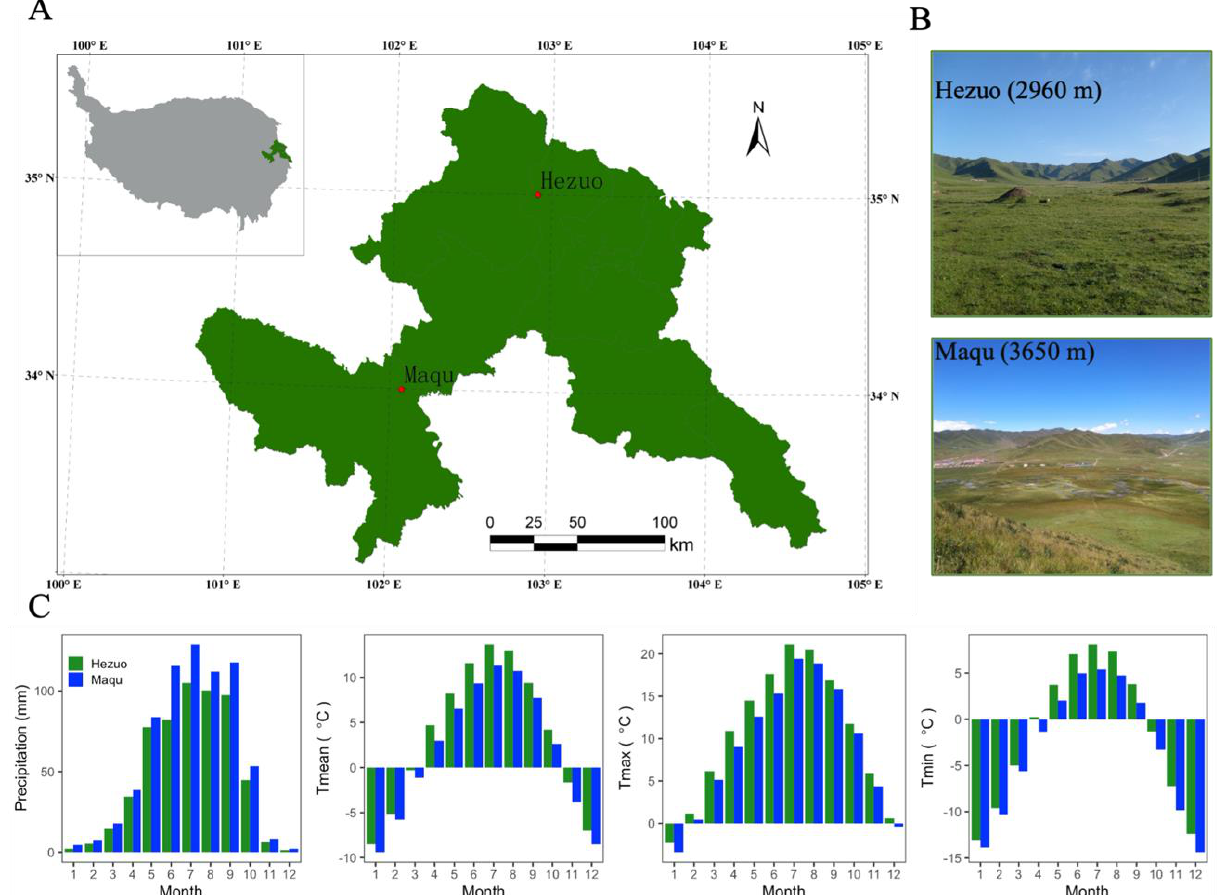
Figure 1. Site location in the Tibetan Plateau (Panel A ), the vegetation landscape (Panel B ), and key climate factors (Panel C ) of the two study sites (Hezuo and Maqu). Tmean, Tmax, and Tmin represent the monthly mean, maximum, and minimum temperature, respectively.